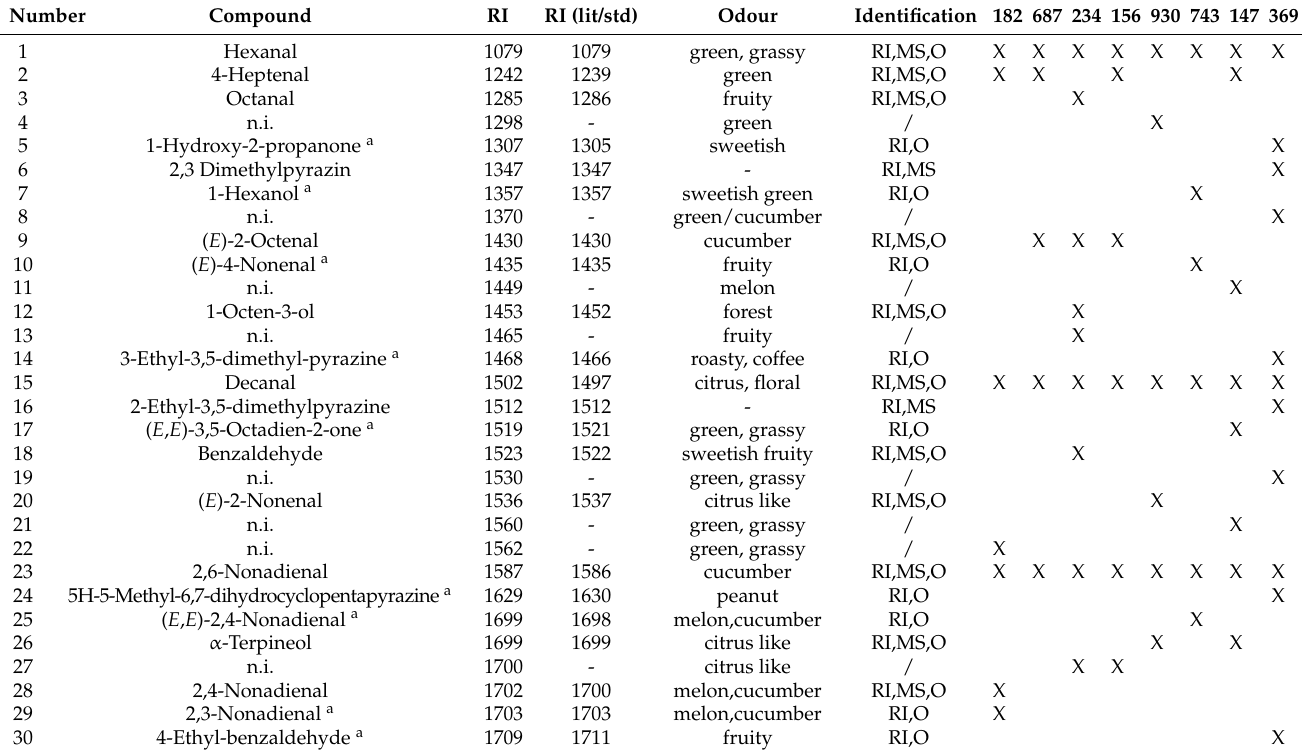
Table A5. Odour-active compounds of the eight tea samples sorted by their retention